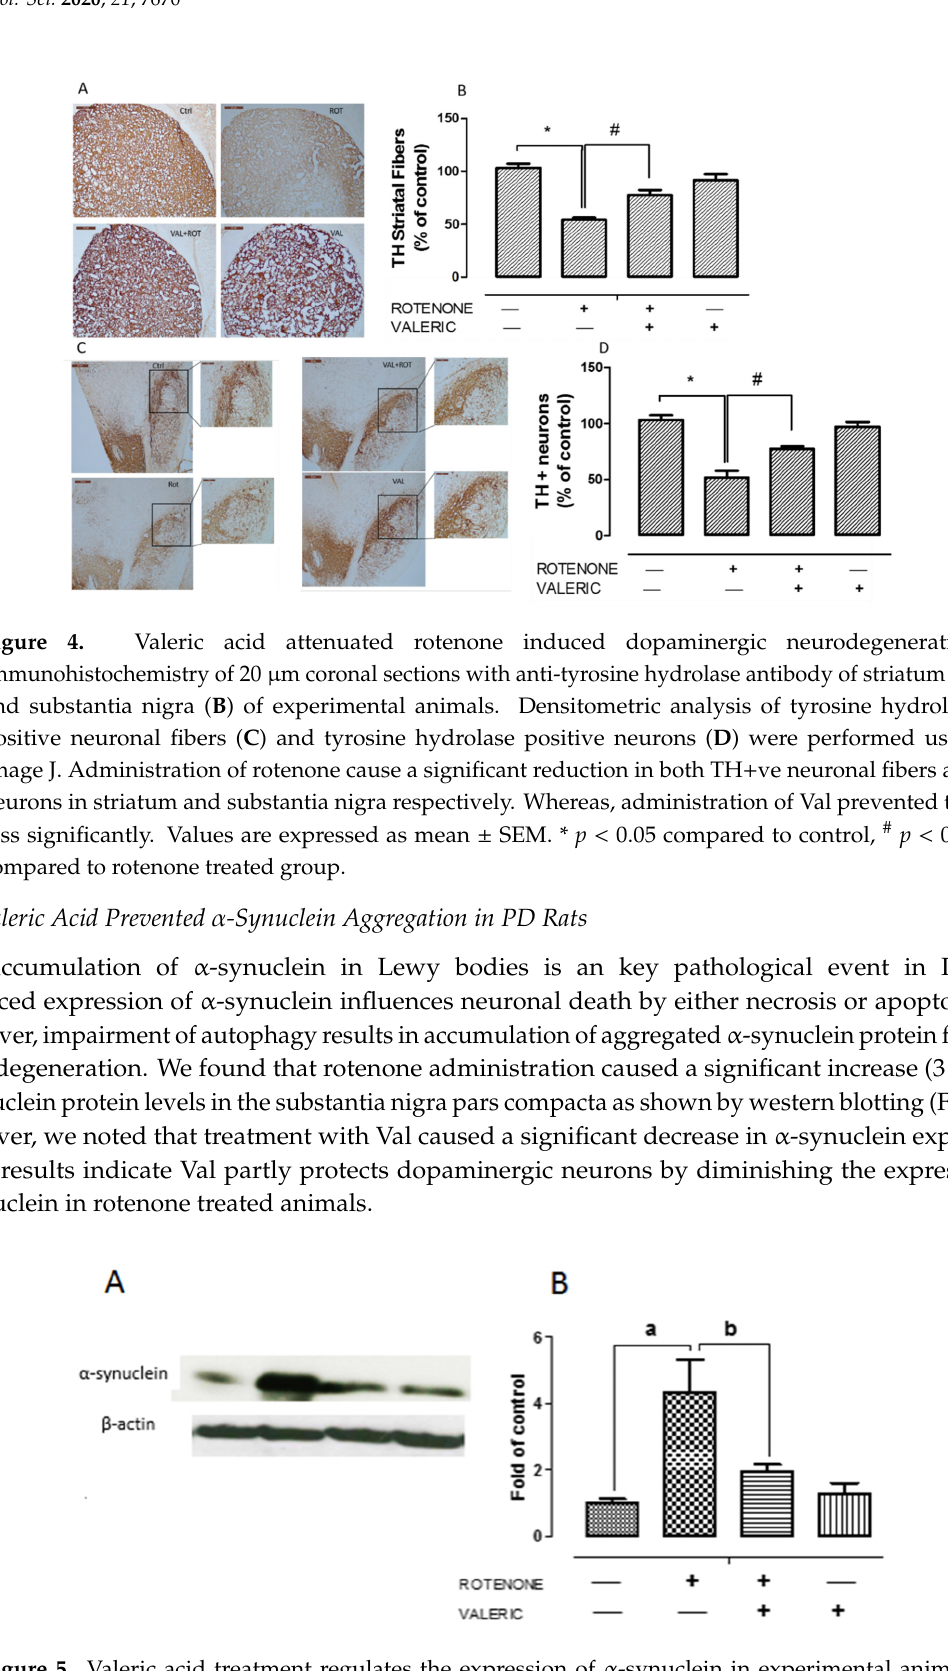
Figure 5. Valeric acid treatment regulates the expression of α -synuclein in experimental animals. Representative immunoblots of alpha-synuclein expression in experimental animals ( A ). Band intensity was quantified using Image J and depicted as bar diagram ( B ). Data are expressed as mean ± SEM. a p < 0.05 compared to control, b p < 0.05 compared to rotenone treated group.